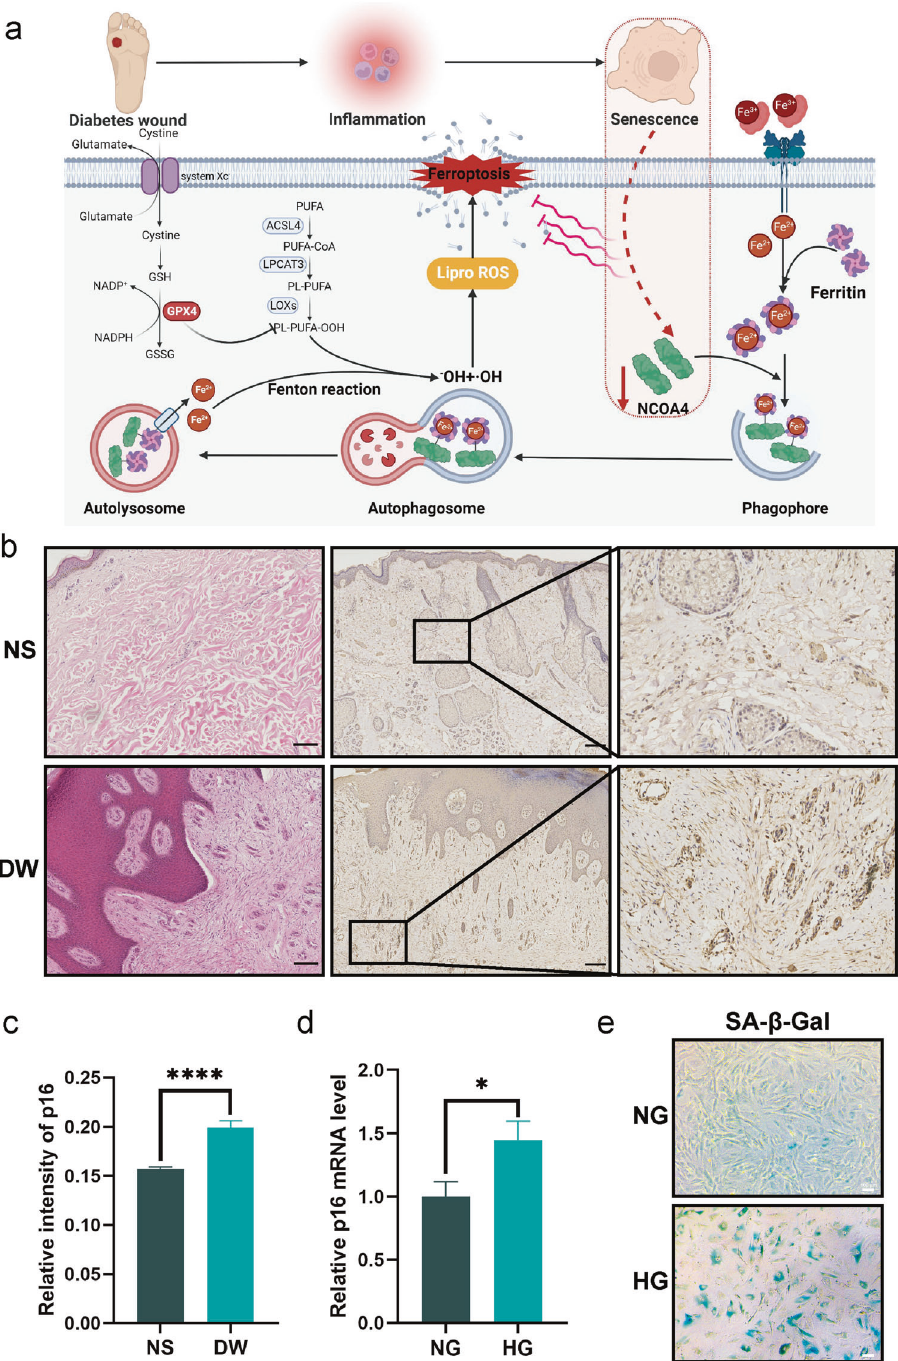
Fig. 1 Senescence is linked to diabetic wounds. a A hypothesized model of the impact of NCOA4 de fi ciency in senescent fi broblasts within diabetic wounds. b Representative H & E staining and immunostaining of p16 photomicrographs illustrating the architecture of diabetes wounds (DW) and normal skin (NS). Scale bar = 200 μ m. c Quanti fi cation of p16 immunostaining in b . d The mRNA level of p16 were detected by real-time PCR in normal glucose cultured fi broblasts (NG) and high glucose cultured fi broblasts (SF). e SA- β -GAL staining illustrates increased senescent fi broblasts after high glucose culture. Scale bar = 100 μ m. Data represent the mean ± SEM of triplicates. * P < 0.05; **** P < 0.0001. lysosome function in senescent cells reduces ferritinophagy [26], breakdown of ferritin and the release of free iron ions, ferritin which partially explains the accumulation of iron and ferritin in metabolism is mostly dependent on ferritinophagy, a form of diabetic wounds. chaperone-mediated autophagy [24]. Notably, autophagy may To con fi rm these hypotheses, we collected tissue samples from suppress senescence by enhancing the quality and quantity of diabetic wounds and analyzed ferritinophagy-related indicators to proteins and organelles, preserving stemness, fostering genomic detect clinical evidence of dysregulated iron metabolic stability, or a combination of these mechanisms [25]. Damage to Cell Death Discovery (2023)